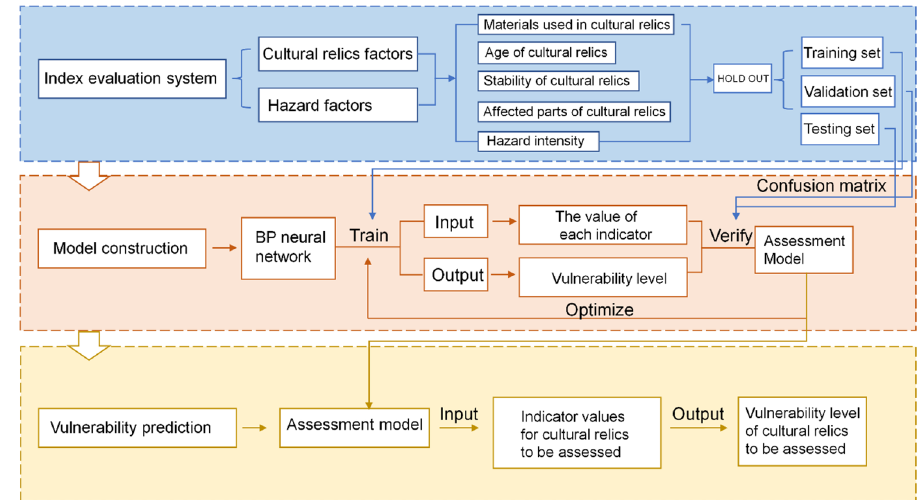
Fig. 2 Technical flowchart for the vulnerability assessment of immovable cultural relics using a back propagation (BP) neural